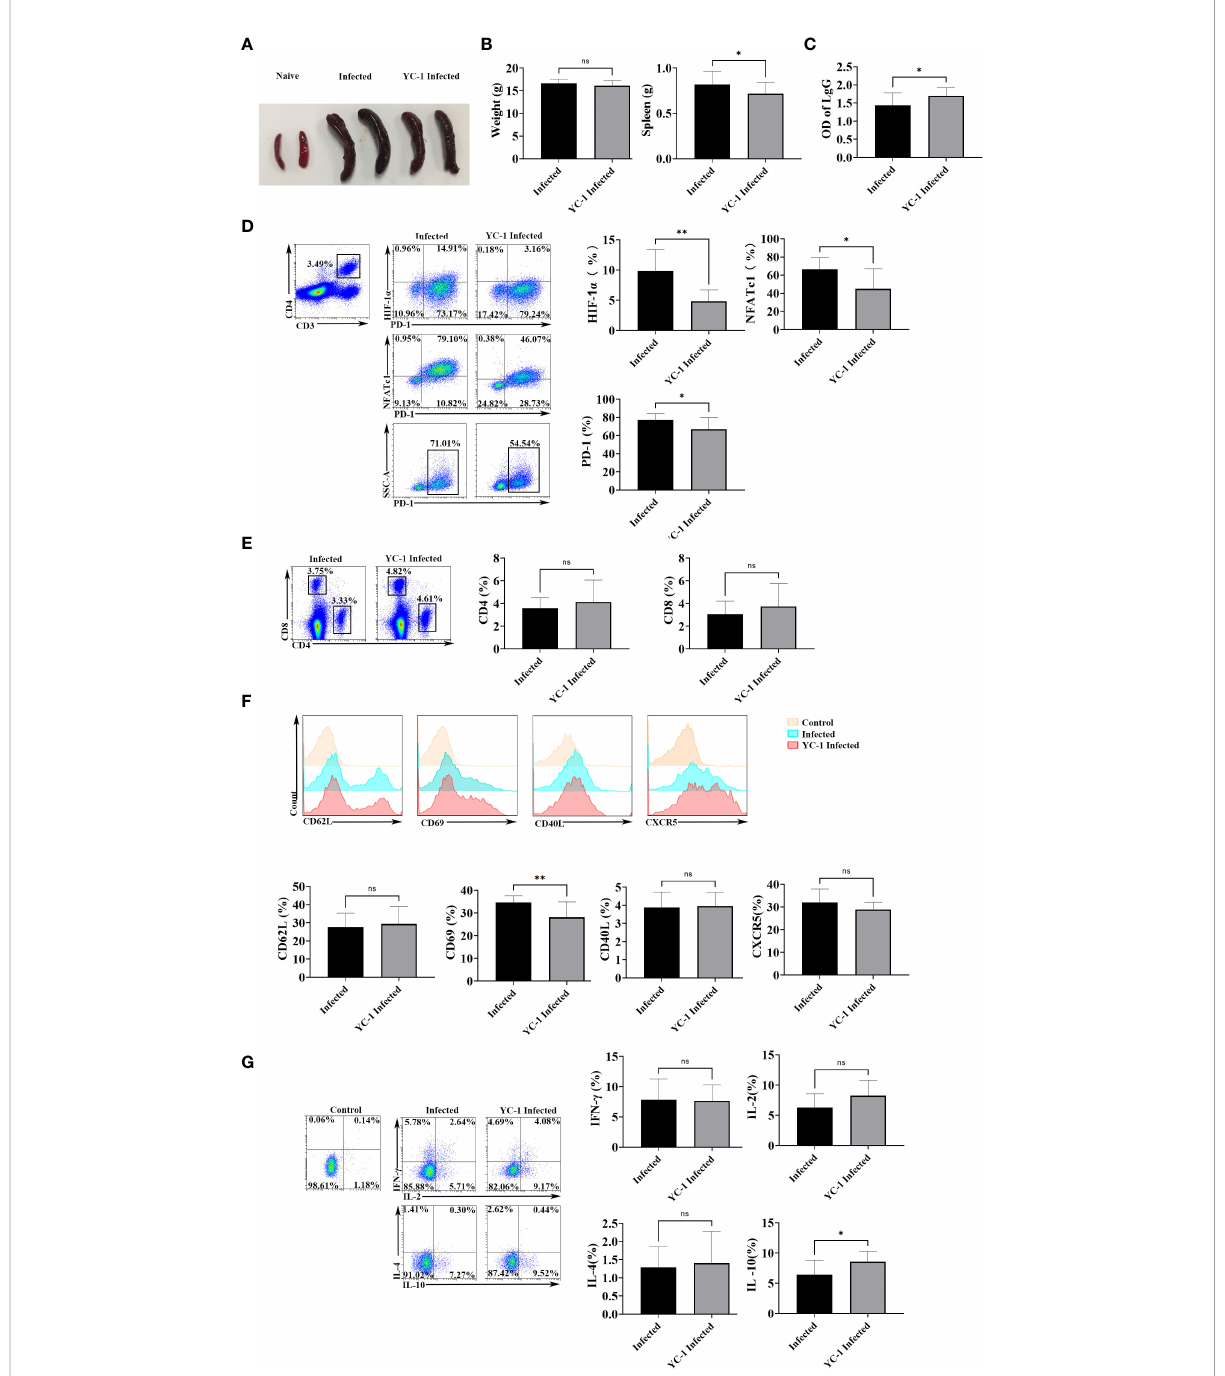
FIGURE 6 HIF-1 a inhibitors possessed the ability to reduce the expression of HIF-1 a , NFATc1, and PD-1. The mice were infected with P. yoelii , and then they were injected with YC-1 every day. The infected mice were set as controls. 12 days post-infection, the spleens were picked out. (A) the appearance of the spleens in the YC-1 infected and the infected groups. (B) the weight and the splenic weight of the mice were compared. (C) the IgG from the serum of the mice was compared. (D) the expressions of HIF-1 a , NFATc1, and PD-1 in CD4 T cells in the infected and YC-1 infected mice were tested by FCM. (E) , the percentages CD4 T cells and CD8 T cells from the infected and YC-1 infected mice were compared. (F) the expressions of CD62L, CD69, CD40L, and CXCR5 in CD4 T cells from the infected and YC-1 infected mice were compared. (G) the percentages of IL-10, IFN- g , IL-2, or IL-4 secreting CD4 T cells from the infected and YC-1 infected mice were compared. 3 – 7 samples were prepared for each group, and the experiments were repeated three times. The error bars represented number of mice. * p <0.05, ** p <0.01. ns, no statistical signi fi